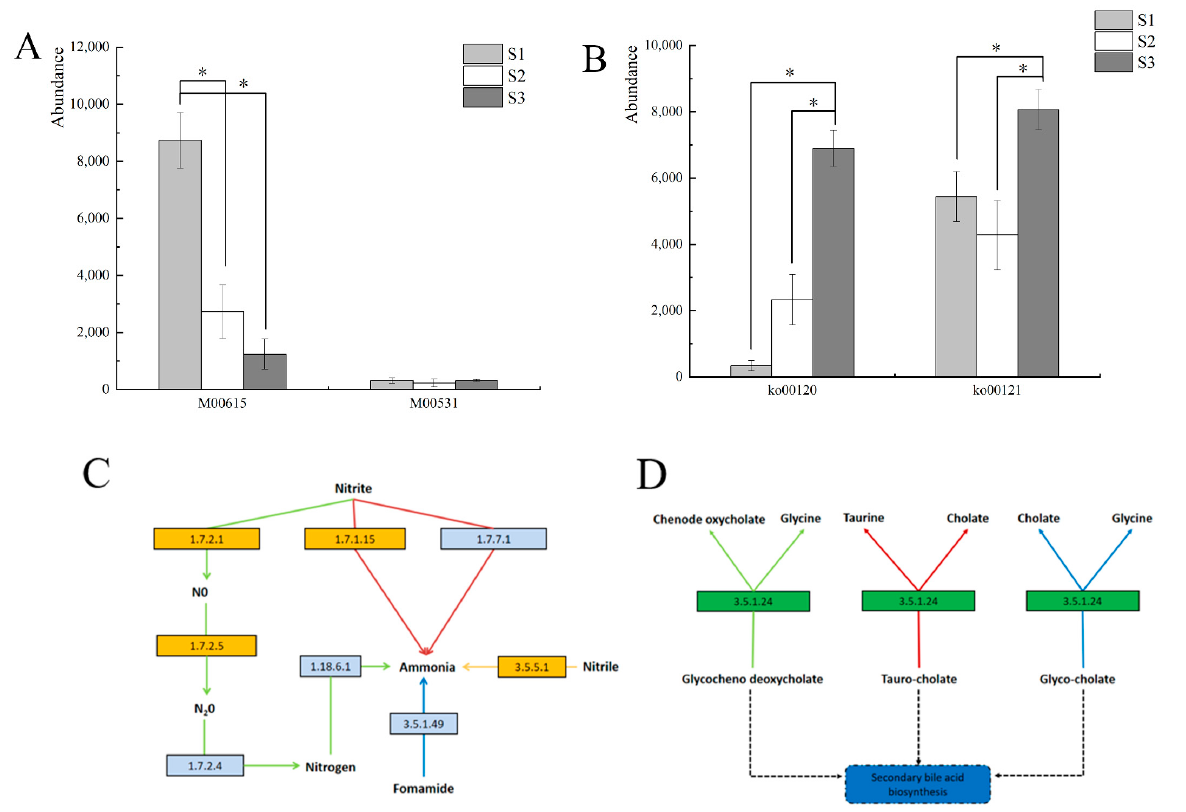
Figure 9. Comparison of nitrite reduction at different fermentation Stages ( A ) and metabolic pathway map ( C ), comparison of pri- map ( C ), comparison of primary bile acid bioanabolism at different fermentation stages ( B ) and mary bile acid bioanabolism at different fermentation stages ( B ) and metabolic pathway map ( D ) (M00615 nitric acid assimilation, metabolic pathway map ( D ) (M00615 nitric acid assimilation, Nitrate assimilation Nitrate Nitrate assimilation Nitrate reduction, M00531 Nitrate reduction Assimilate, Ko00120 Primary bile acid biosynthesis, Ko00121 Sec- ondary bile acid biosynthesis Green indicates that the enzyme abundance in S3 stage is higher than S1 stage, and yellow indicates that the enzyme abundance in S1 stage is higher than S3 stage ， * p < 0.05).